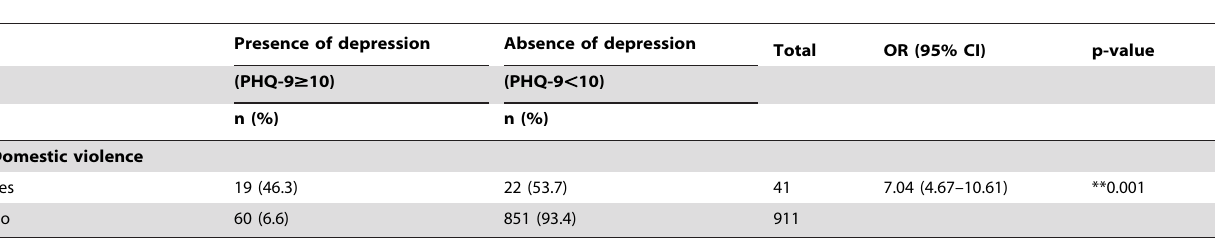
Table 6. Association of domestic violence with depression among ever married participants (n=952).